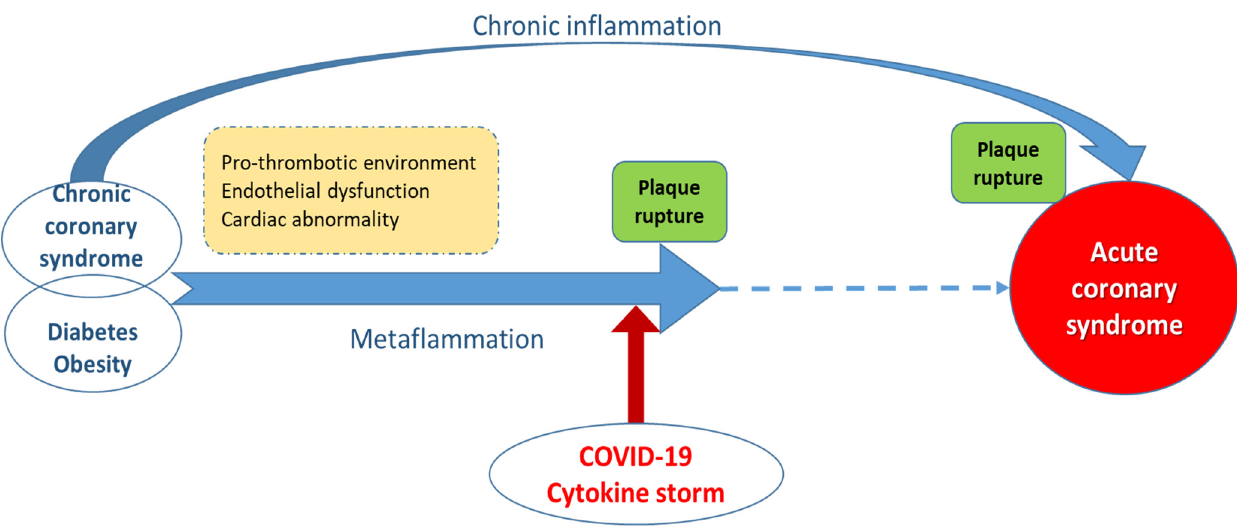
Figure 1. The link between COVID-19 cytokine storm and acute coronary syndrome (ACS). Usually, ACS is produced by the rupture of an atheromatous plaque, after a long evolution of a chronic coronary syndrome, which may be associated with persistent, long-term inflammation. The sudden augmentation of systemic inflammation in the context of cytokine storm initiated by COVID-19 disease may trigger early rupture of a pre-existing plaque and consequent ACS.